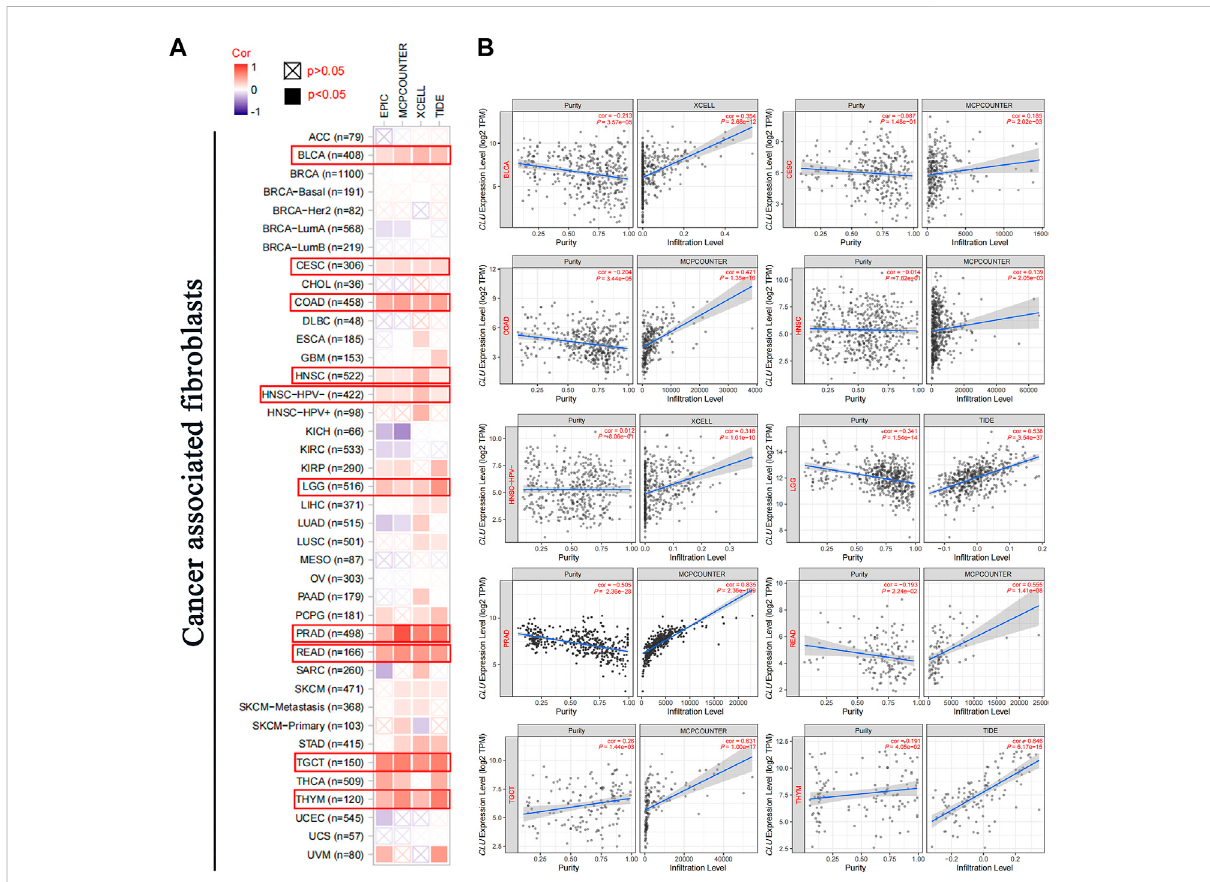
FIGURE 6 Correlation investigation of CLU gene expression and CAFs immune in fi ltration. (A) For all TCGA tumors, different algorithms (MCPCOUNTER, EPIC, XCELL, and TIDE) were used to assess the connection between CLU expression and the amount of immunological in fi ltration of CAFs; (B) scatterplot of the chosen tumor was provided, which was created using one of the